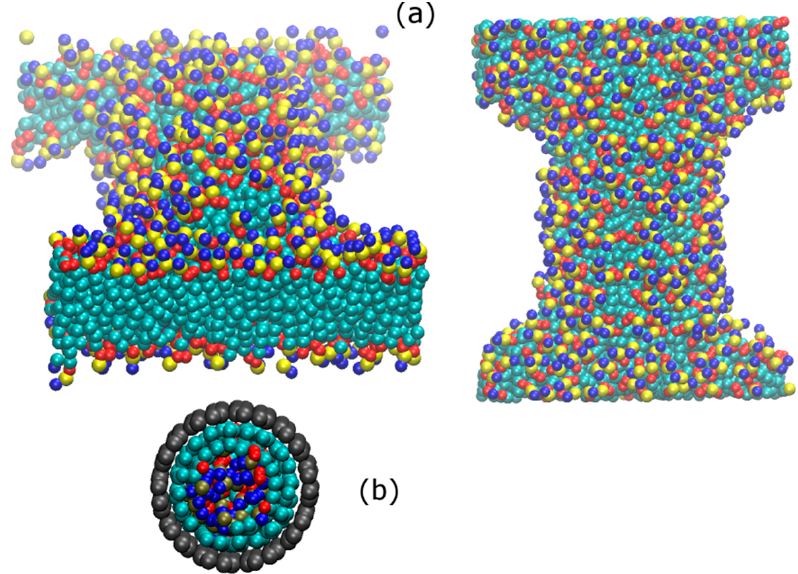
Figure 4. Snapshots of a simulation box showing ( a ) surface saturation of CNT (20, 20) with DPPC molecules and formation of a bilayer, as well as ( b ) adsorption of lipid molecules on the inner surface of CNT (34,34). In panel ( a ), the left and right snapshots indicate views along the tube ( y ) and normal to the tube ( z ) axes, respectively. The DPPC molecules dissolved in the solution (500 molecules) adsorb on the surface of the CNT to form a complete monolayer. The excess DPPC molecules form a bilayer at the CNT ends, spanning the simulation box in the x and y directions.